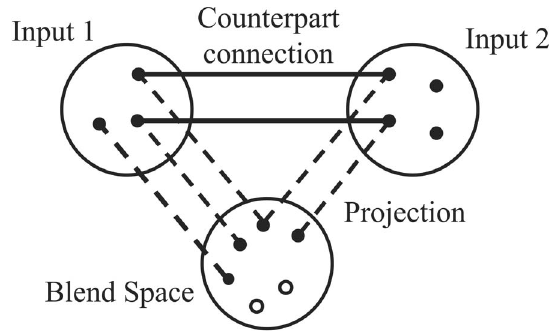
FIG. 3. Conceptual blending diagram. Adapted from